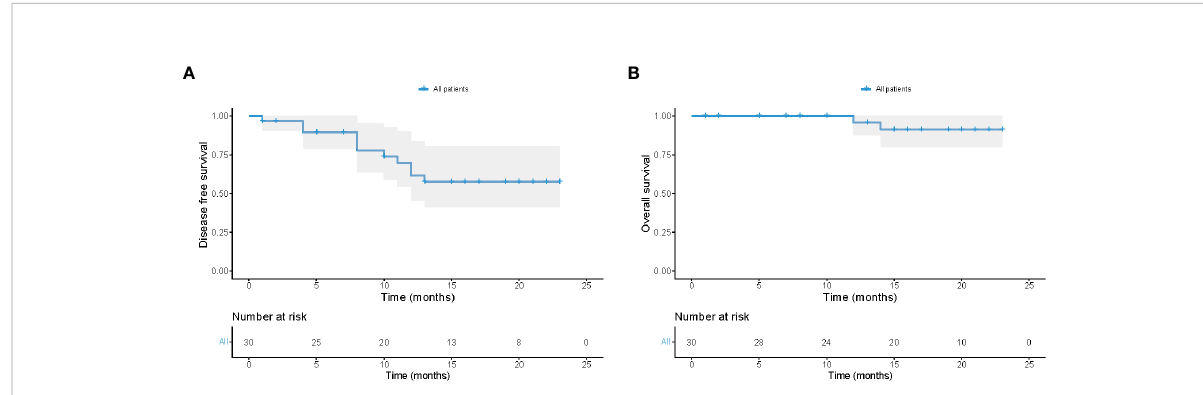
FIGURE 6 Follow-up of all 30 patients receiving conversion surgery. Kaplan-Meier plots of disease-free survival (A) and overall survival (B) in all 30